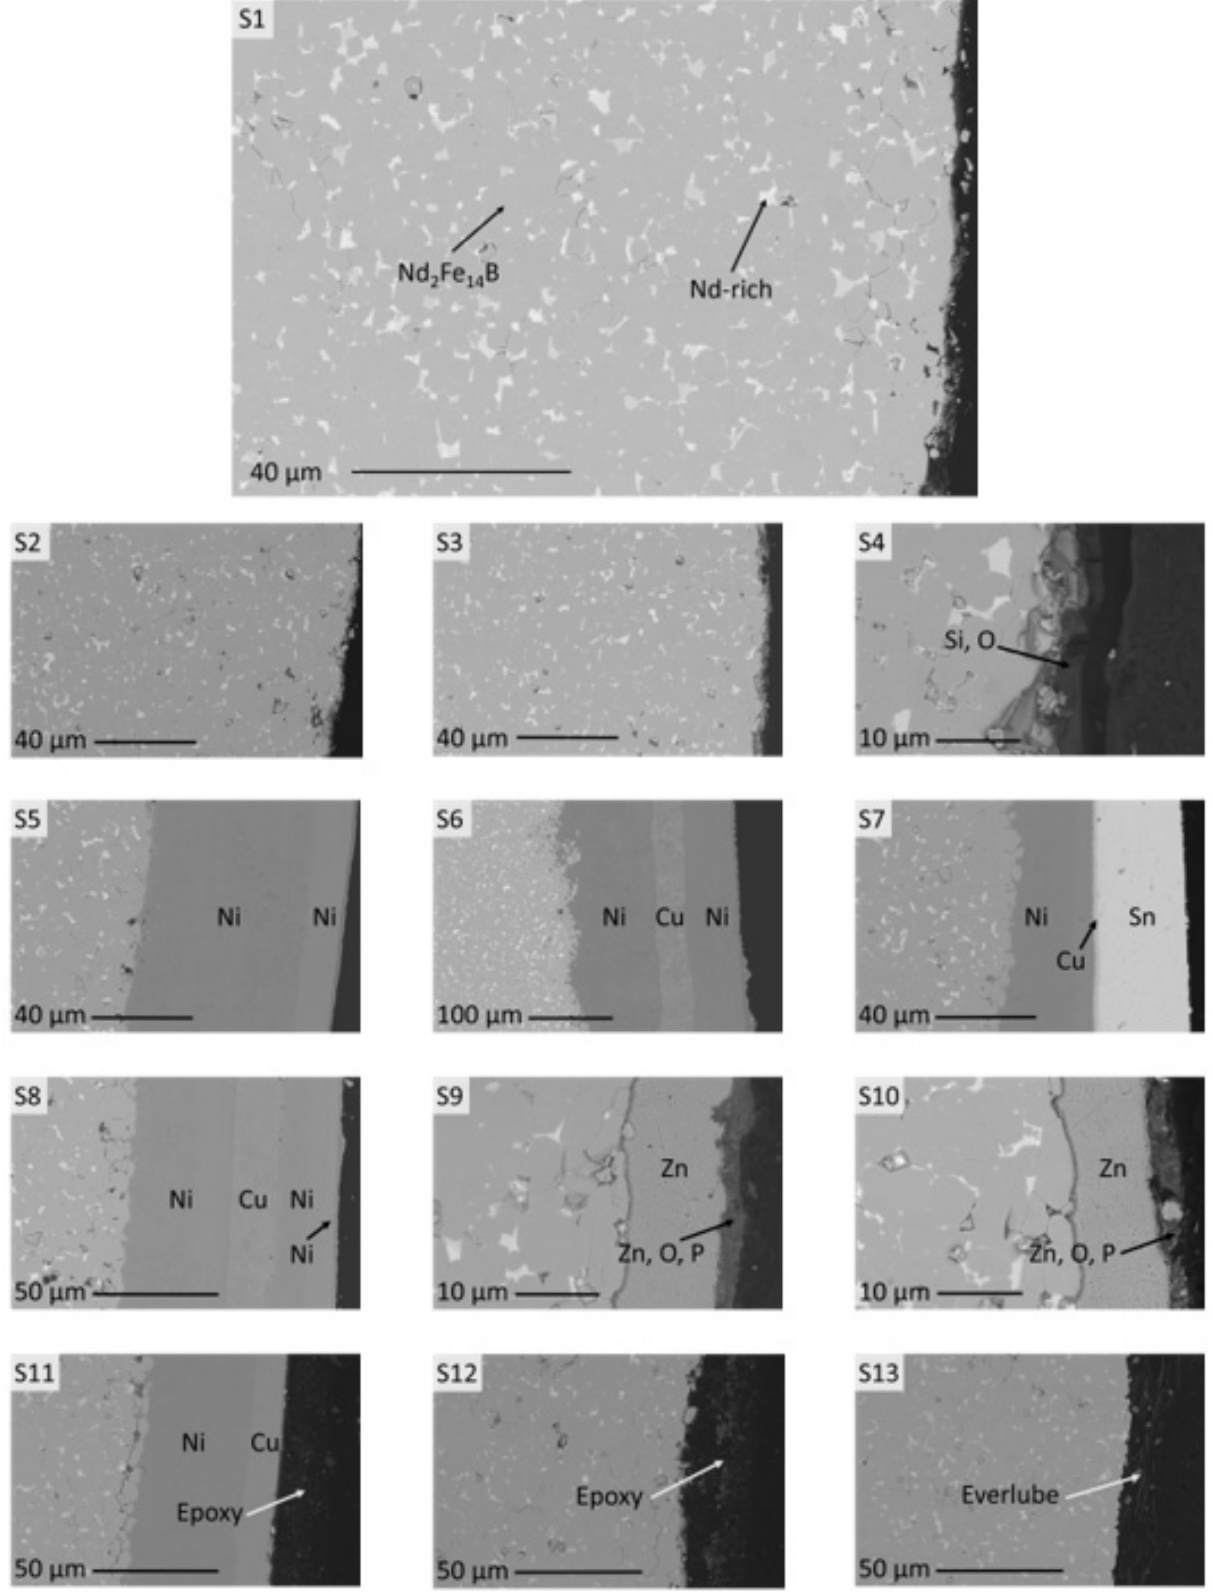
Figure A2. SEM images of the investigated NdFeB magnet samples S1–S13 showing microstructure and coatings.